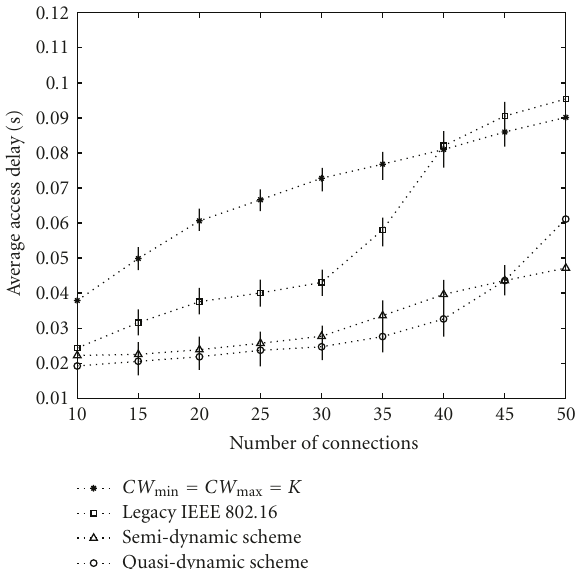
Figure 7: Average access delay versus number of connections.